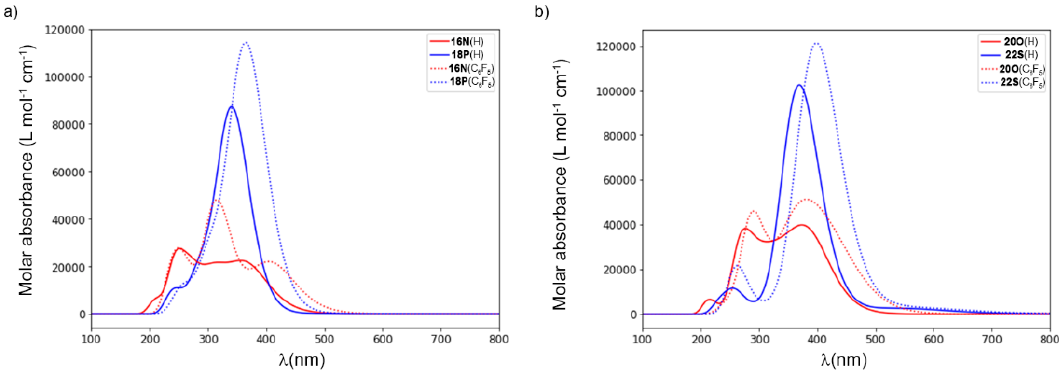
Figure 16. Evolution of the UV/vis absorption spectra upon meso -substitution for ( a ) (16)norcorrole and (18)porphyrin; ( b ) [20]orangarin and [22]smaragdyrin.